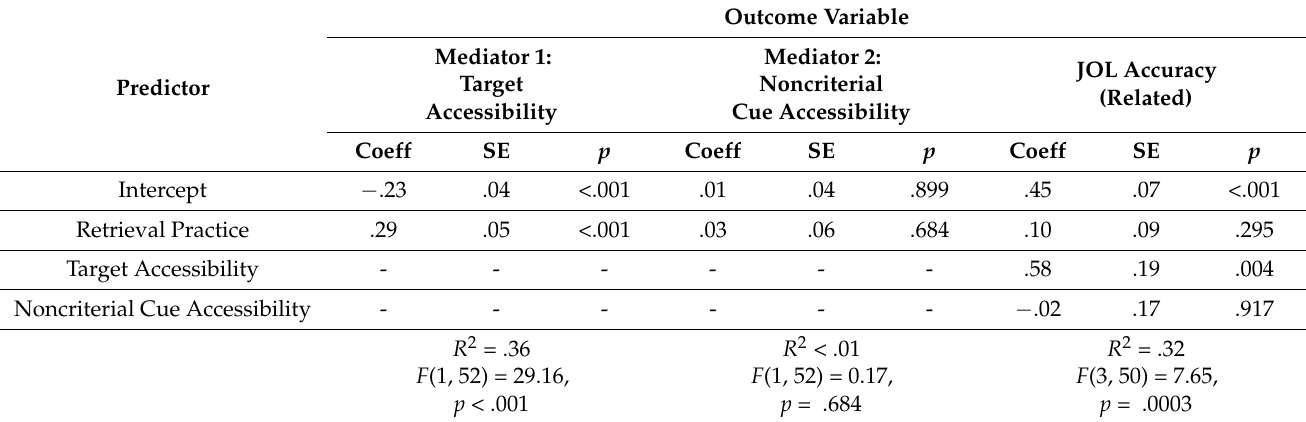
Table 5. Experiment 1—Mediation Model